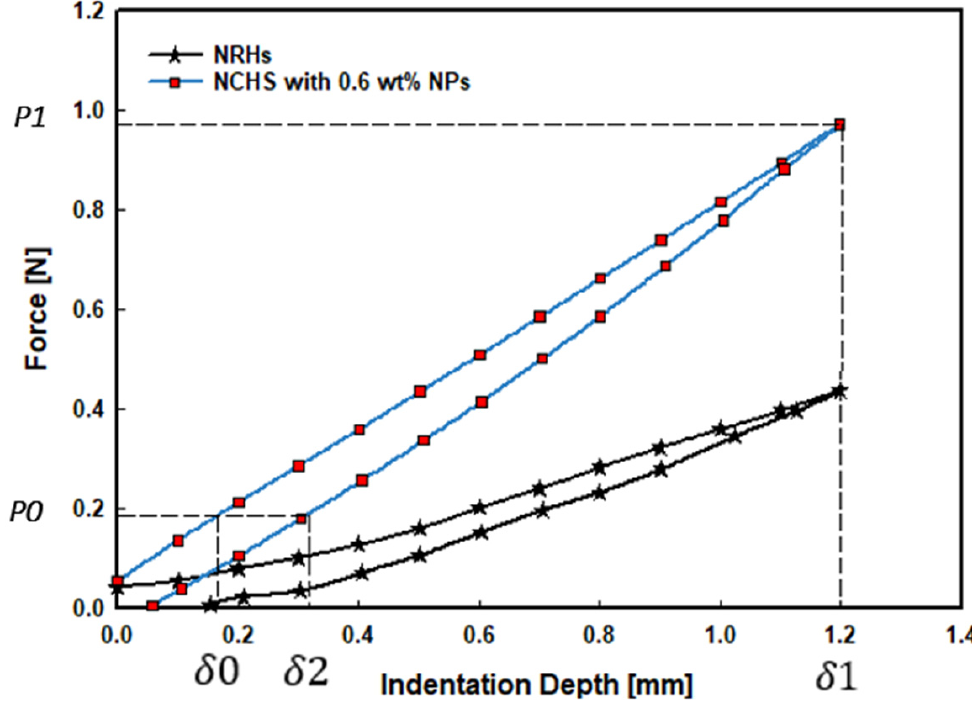
Figure 5. Load-displacement graphs for NRHs and 0.6 wt% loaded NCHs.